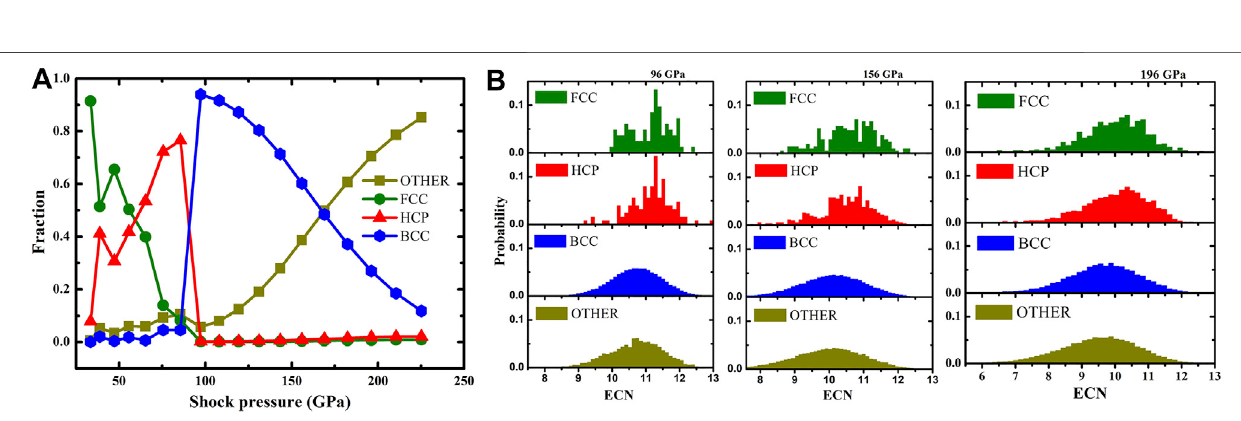
Frontiers in Physics |